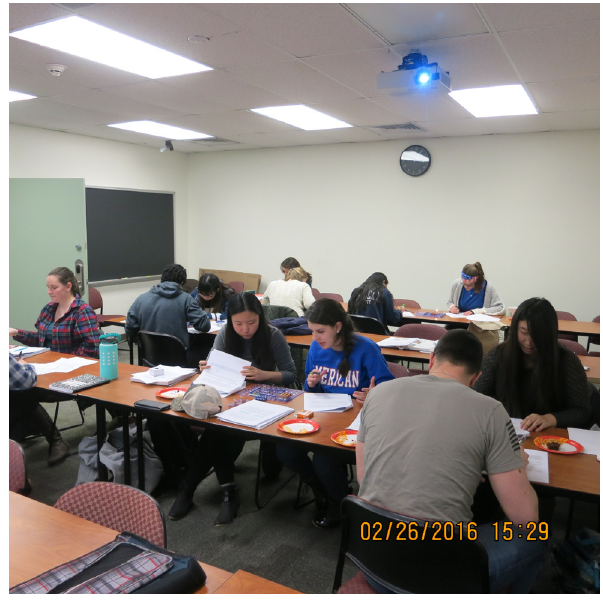
Fig. 2. Students explore electric circuits in a workshop/studio